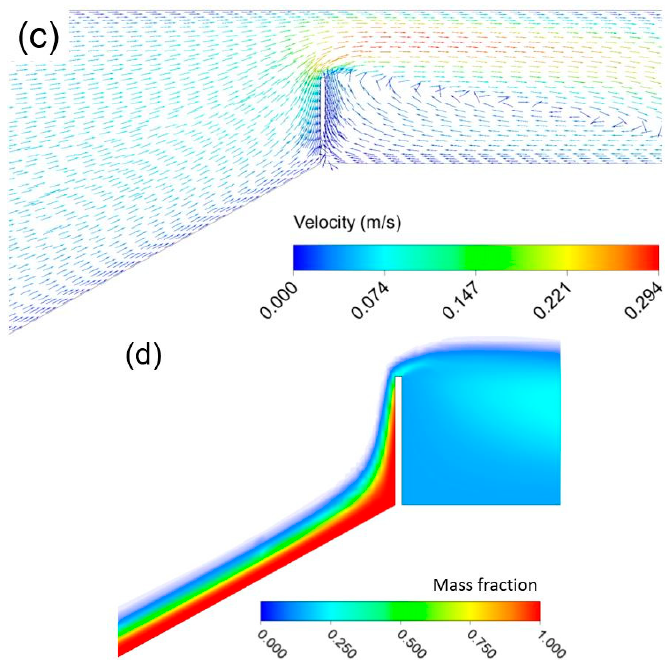
Figure 1. Controlling the hydrodynamics of the CVD process towards atmospheric chemical vapor deposition of nanowires. ( a ) Schematic illustration of di ff usion of a compound from fluid with partial pressure of P g through a CBL with partial pressure of P i , fluid-catalyst interface with partial composition of C i , to catalyst droplet with C l partial composition. The e ff ective parameters on the interfacial gas–liquid mass transfer flux ( J ), including fluid velocity ( v ), are shown. ( b ) CVD synthesis of nanowires: an alumina boat loaded with a mixture of source materials (1:1 wt of Ga 2 O 3 and ZnO) was placed at the centre of a horizontal tube furnace at source temperature (T s ). The furnace geometry downstream was modified using an alumina filler. The Si (100) substrate was secured at growth temperature (T g ) in a vertical position at a distance from the centre of the heated zone (D) downstream of the source materials. The schematic temperature profile of the tube furnace, concentration of ammonia (NH 3 ) carrier / reactant gas and schematic Ga and Zn atoms’ building blocks are shown. ( c ) Velocity profile of the gaseous reactants at the vicinity of Au-coated substrate calculated by computational fluid dynamics, showing high local velocity near the surface of the substrate, which enhances the concentration gradient and, subsequently, the local mass transfer coe ffi cient (the length and colour of the vectors represent the velocity magnitude). ( d ) Mass fraction profile of the mix-metal oxynitride building blocks, calculated by computational fluid dynamics, showing a high local concentration gradient on the surface of the substrate.